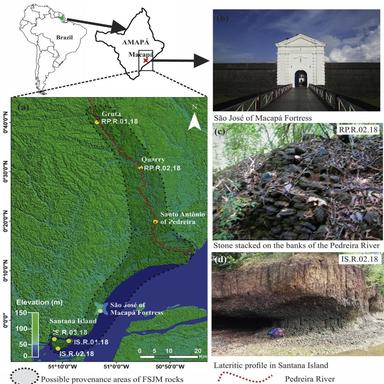
Location of the Fortress of São José de Macapá (FSJM) (b) and possible provenance areas of FSJM rocks investigated in this research (a): stone stacked on the banks of the Pedreira River (c); lateritic profile in Santana Island (d).